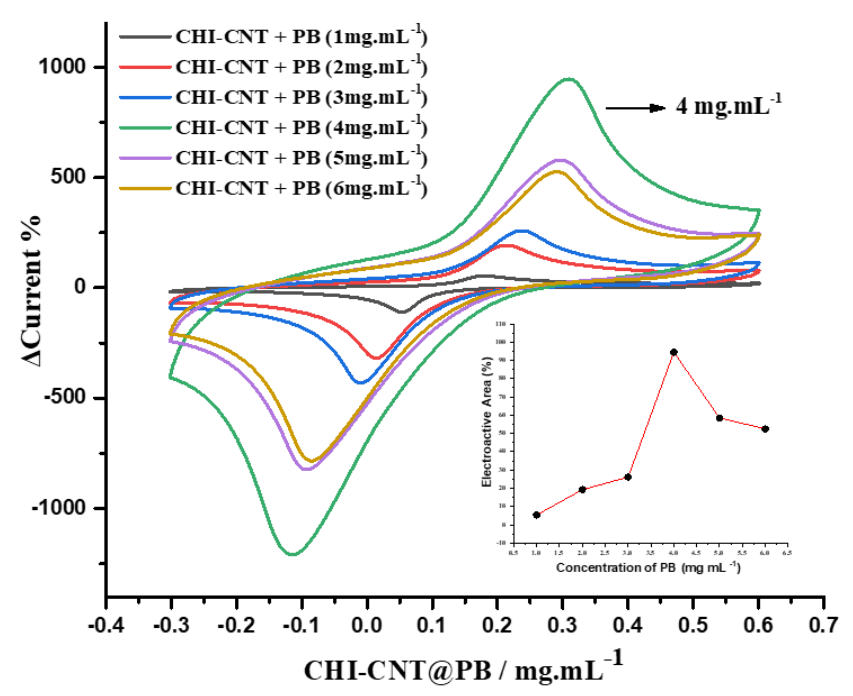
Figure 3. CV profiles according to the PB concentration (inset: electroactive area as function of different PB concentrations). Measurements performed in 100 mmol · L − 1 KCl at 0.05 V · s − 1 scan rate.